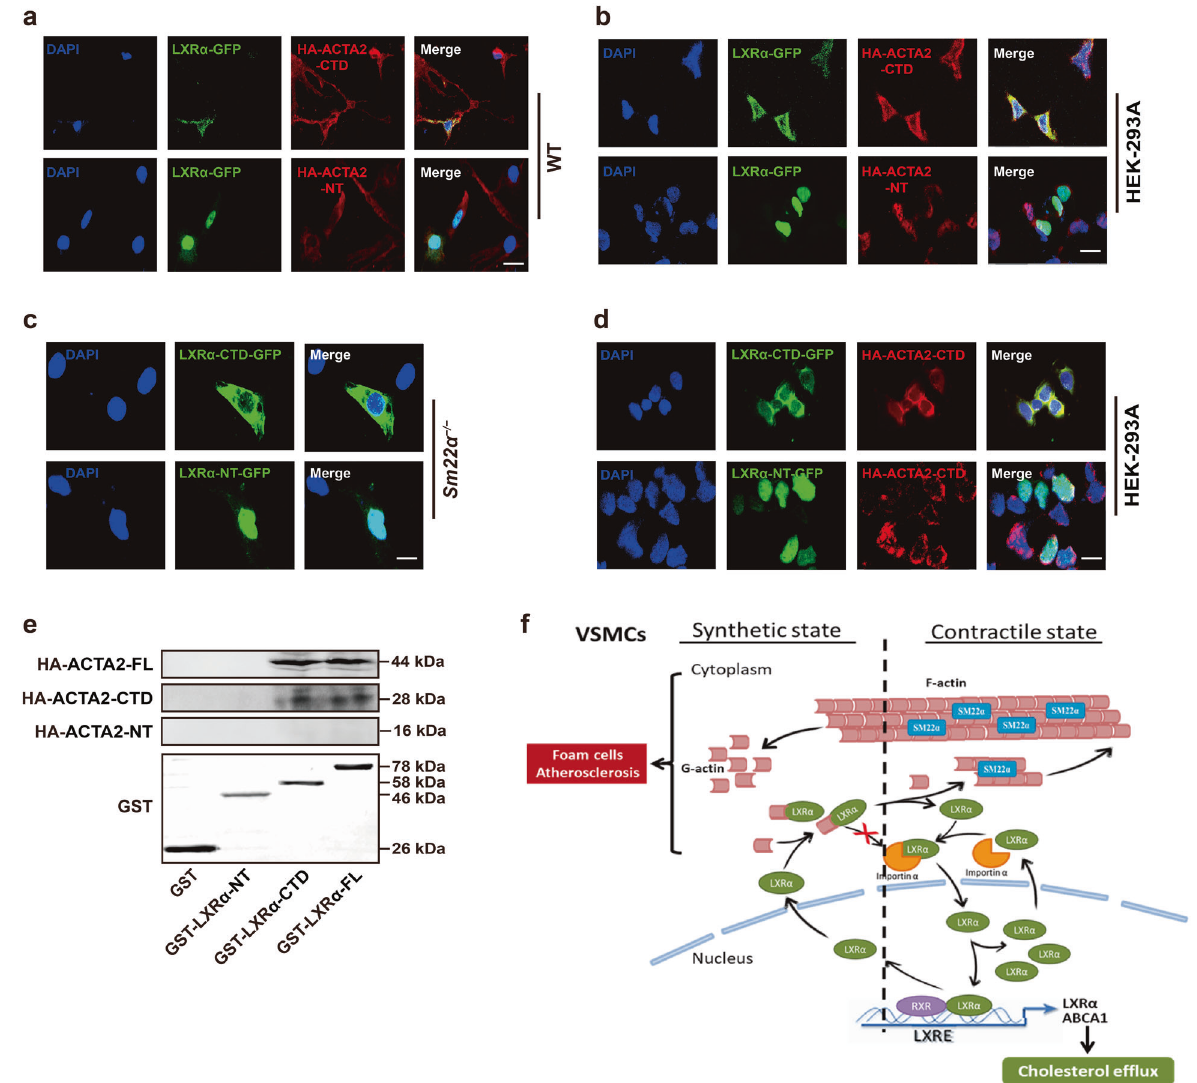
Fig. 6 The C-terminal domain mediates interaction between G-actin and LXR α . a Representative immuno fl uorescence staining for LXR α - GFP (green) in WT VSMCs transfected with HA-ACTA2-CTD (red) or HA-ACTA2-NT (red). Scale bar, 15 μ m. b Representative immuno fl uorescence staining for LXR α -GFP (green) and HA-ACTA2-CTD (red) or HA-ACTA2-NT (red) in HEK-293A cells. Scale bar, 15 μ m. c LXR α -CTD-GFP (green) or LXR α -NT-GFP (green) was transfected into Sm22 α − / − VSMCs. Scale bar, 10 μ m. d LXR α (-CTD, -NT)-GFP (green) and HA-ACTA2-CTD (red) were co-expressed in HEK-293A cells. Scale bar, 10 μ m. e Interaction of HA-ACTA2 (-FL, -CTD, -NT) and GST-LXR α (-FL, -CTD, -NT) proteins analyzed by in vitro pull-down assay ( n = 3). f Schematic representation of a working model which SM22 α inhibits VSMC- derived foam cell formation by blocking actin-LXR α signaling ameliorating atherosclerosis. Data and images represent at least three independent experiments.